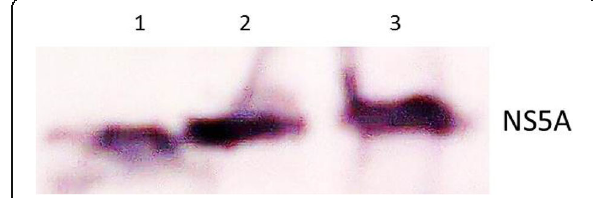
Fig. 9 NS5A.1 antigenic site protein expressed in bacterial cells (gene specific). Lanes 1 – 3: NS5A.1 antigenic protein